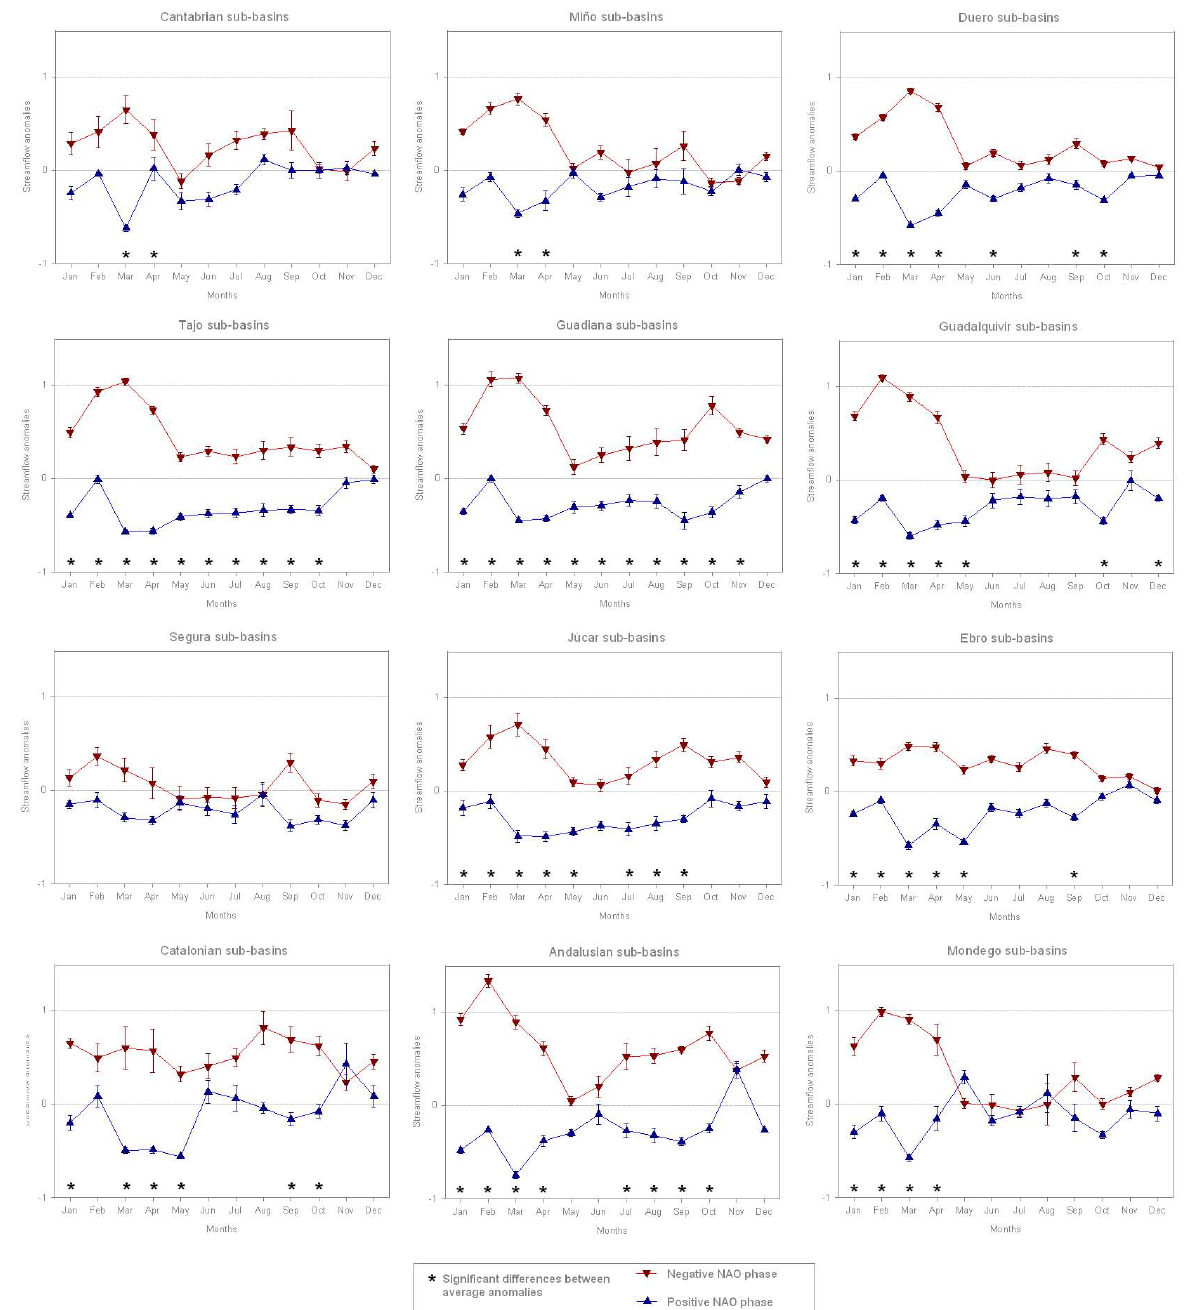
Fig. 5. Statistical summary of the streamflow anomalies registered during positive and negative winter NAO phases classified by major basins. Triangles represents the mean of the streamflow anomalies registered in every sub-basin gauge. Whiskers represents the mean’s standard error. Asterisks depicted significant differences between mean positive and negative anomalies, obtained by means of the Wilcoxon Mann Whitney